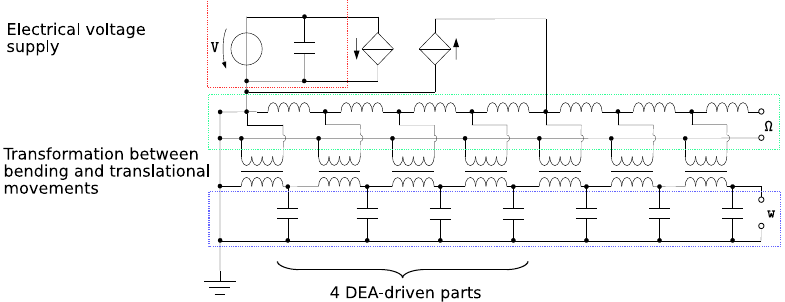
Figure 10. Electromechanical network model of the bending structure, red: electrical domain, green: rotational domain, blue: translational